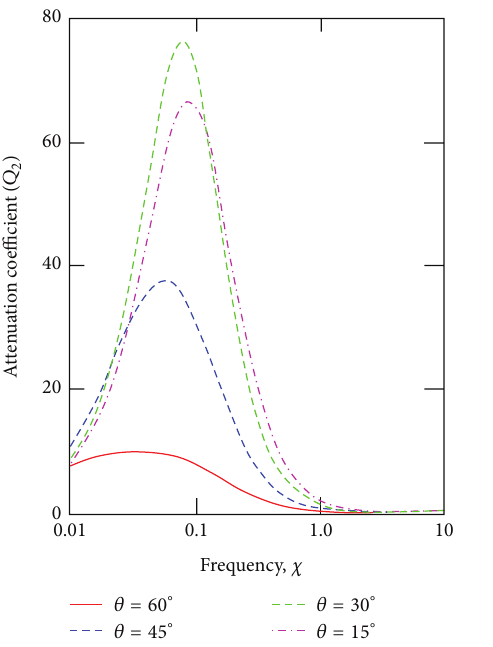
Figure 6: Variation of attenuation coefficient of the N-mode with nondimensional frequency in various direction of